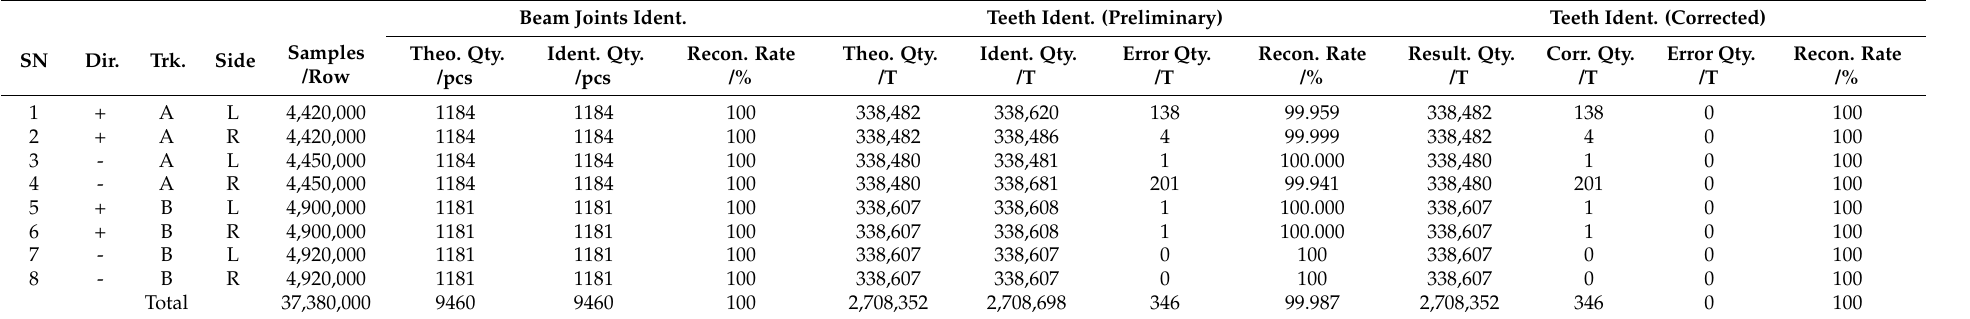
Table 3. Summary of locating calculation